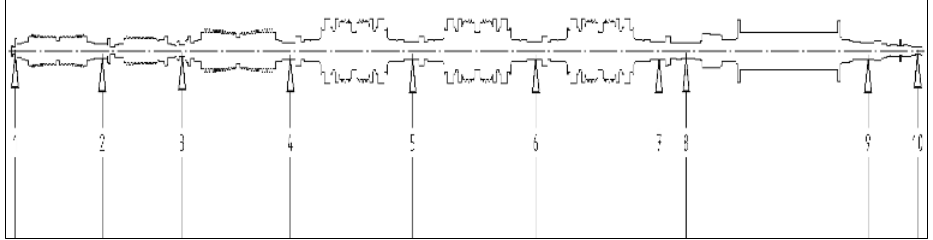
Fig. 2. The distribution diagram of the six-cylinder and six-exhaust steam support points and shafting.